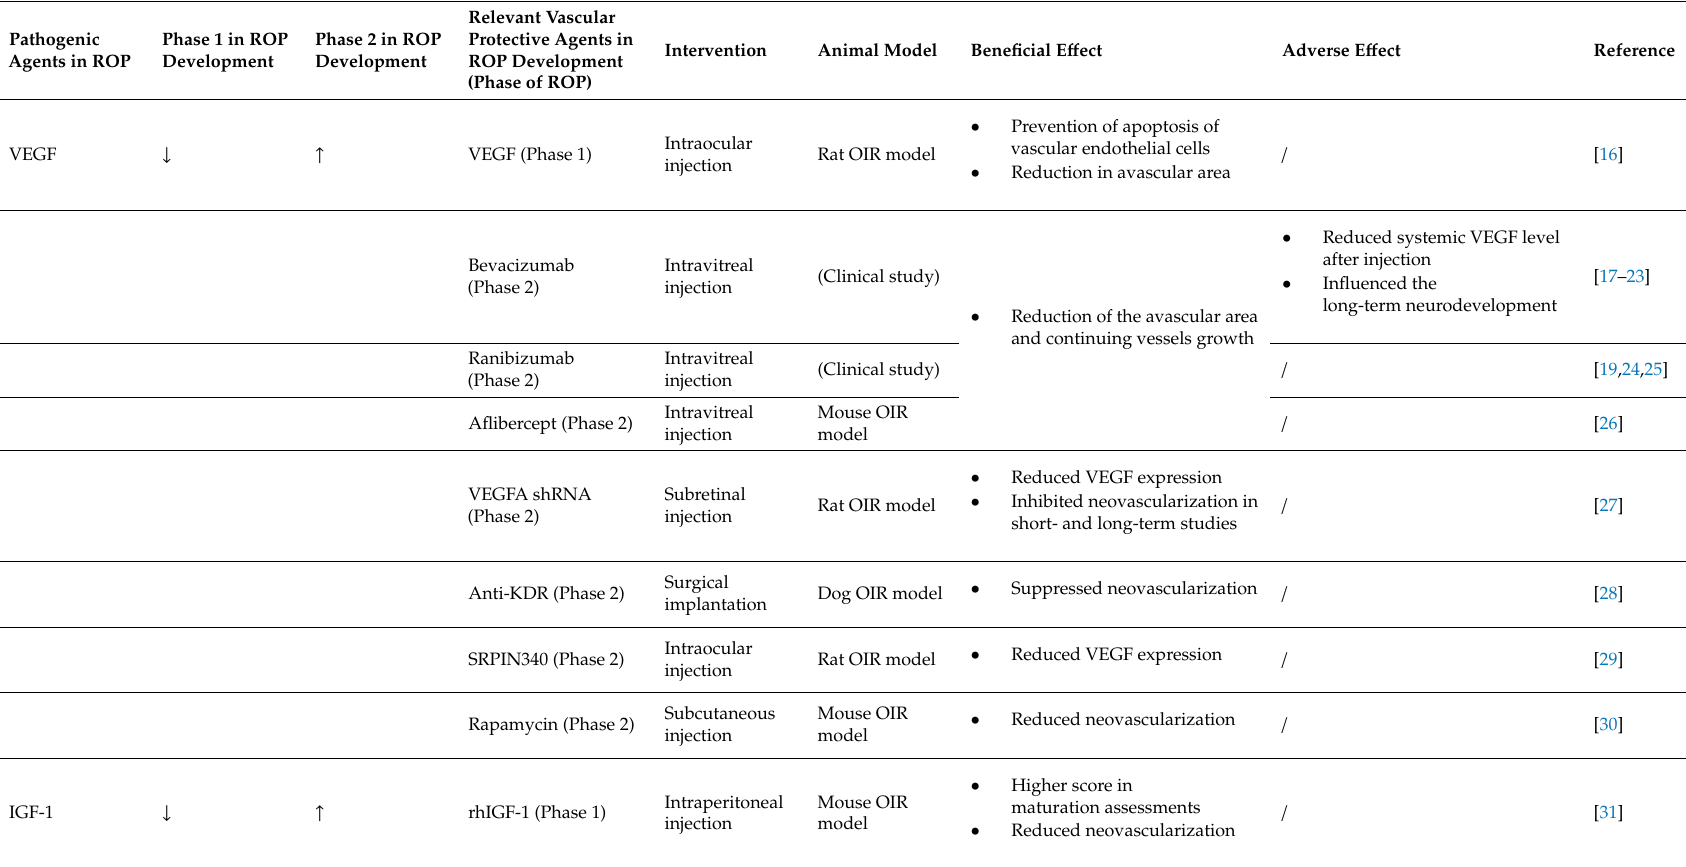
Table 1. Vascular protective agents in the role of ROP